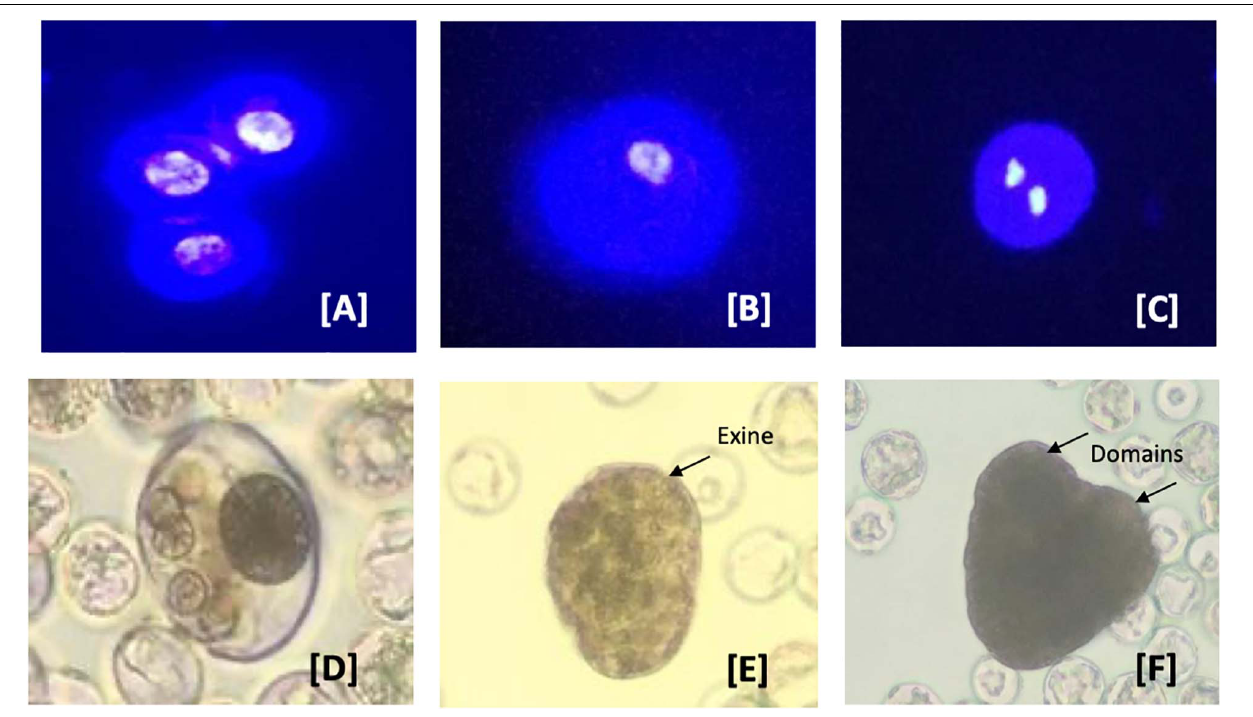
FIGURE 5 | Developmental pathways observed in C. sativa (industrial hemp) microspore culture. (A–C) Male gametophyte development in C. sativa during in vitro culture. (A) Uninucleate microspores; (B) uninucleate microspores after 3 days in culture media; (C) symmetrically divided microspore with two equally sized nuclei;